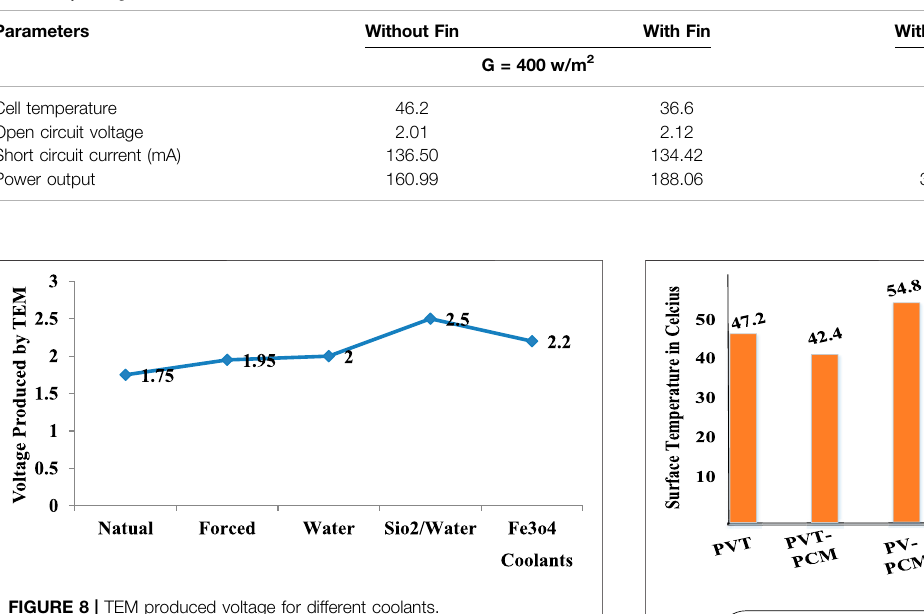
FIGURE 8 | TEM produced voltage for different coolants.